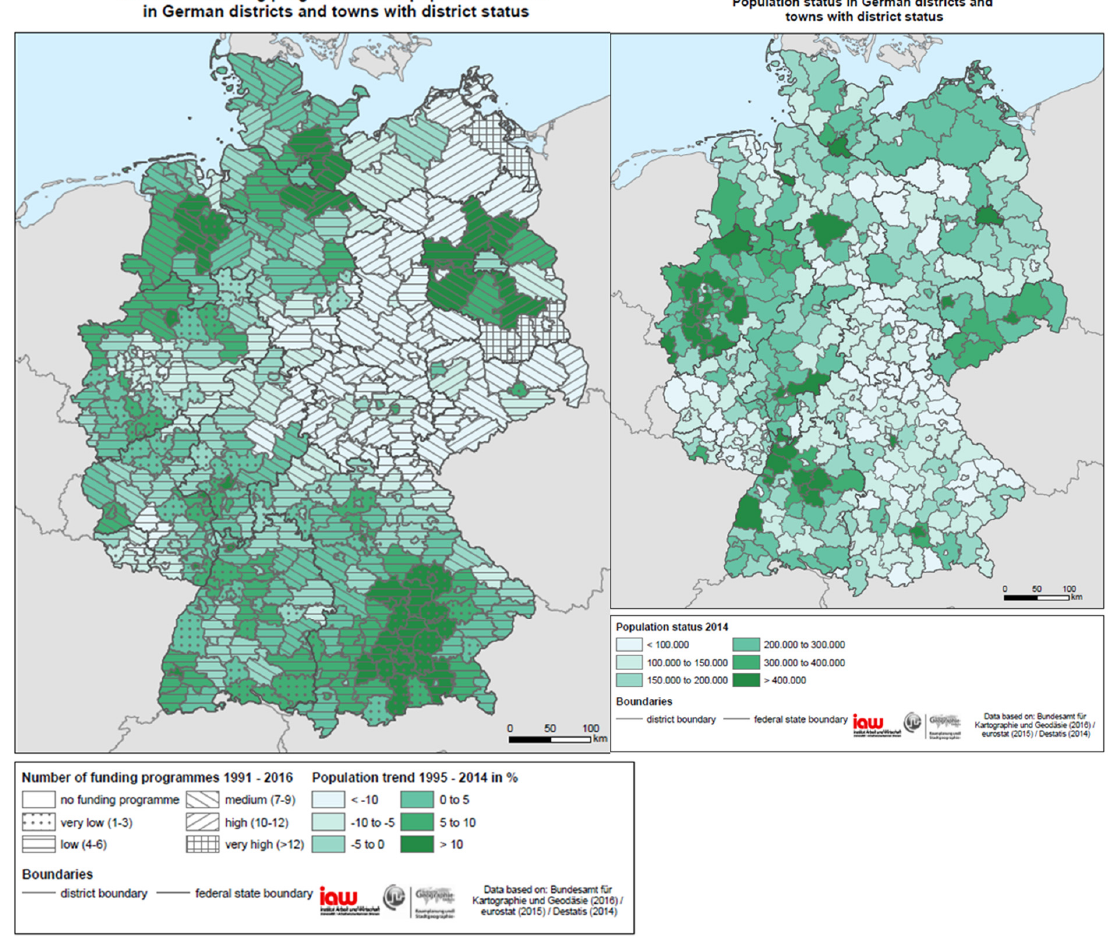
Figure 8. Number of programmes and population trends in German districts and towns with district status ( left ) and the population status of German districts and towns with district status ( right ). Source: authors’ compilation (Department of Geography Giessen, Institute for Labour and the Economy Bremen).